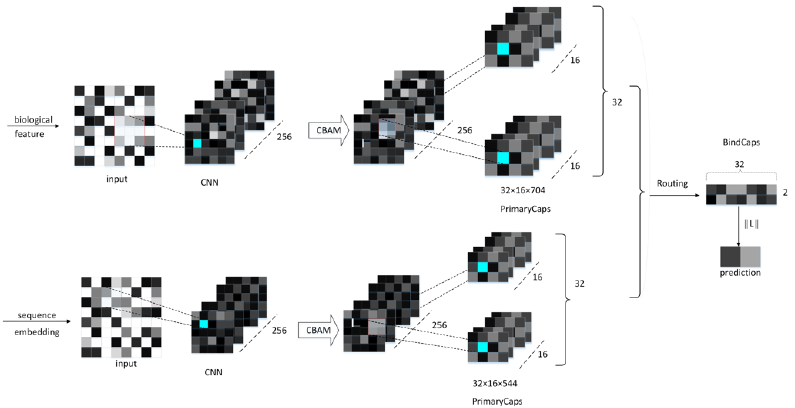
Figure 8. The neural network framework of the proposed method. Subsequently, the biological and sequence features processed by CBAM are con ‐ verted into 32 × 16 × 544, 32 × 16 × 704 feature maps and then inputted to the PrimaryCaps layer. To be specific, 32 represents the number of peptide chains input in one training, 16 indicates the number of channels in the PrimaryCaps layer, and 544 and 704, respectively, represent the size of the biological and sequence feature information obtained after CBAM. For the feature map corresponding to the respective peptide chain, the calculation of the iterative dynamic routing between the PrimaryCaps and BindCaps layers is illus ‐ trated in Figure 9. To be specific, the PrimaryCaps layer comprises 1248 (544 + 704) cap ‐ sules 𝑢 (cid:3036) (each 𝑢 (cid:3036) denotes a 16 ‐ dimensional vector), and each capsule is multiplied by the weight matrix W I , j (the size 16 × 32, i = 1,…,1248, j = 1,2) to obtain 𝑢(cid:3548) (cid:3036) | (cid:3037) . 𝑢(cid:3548) (cid:3036) | (cid:3037) is multiplied by the weighted sum of the parameters 𝑐 (cid:3036) , (cid:3037) to yield 𝑠 (cid:3037) . Subsequently, through the non ‐ linear “Squeeze” function, the capsule vector in BindCaps is obtained after a set number of iterations (epoch). To be specific, the “squeeze” function [15] is adopted to scale the length of the output vector of each capsule to between [0, 1] and keep the direction un ‐ changed, as expressed below: 𝑣 (cid:3037) (cid:3404) (cid:3630)𝑠 (cid:3037) (cid:3630) (cid:2870) 1 (cid:3397) (cid:3630)𝑠 (cid:3037) (cid:3630) ∙ 𝑠 (cid:3037) (cid:3630)𝑠 (cid:3037) (cid:3630) (11) where 𝑠 (cid:3037) and 𝑣 (cid:3037) , respectively, represent the input and output of the j ‐ th capsule. Figure 9. Routing calculation process between PrimaryCaps and BindCaps.